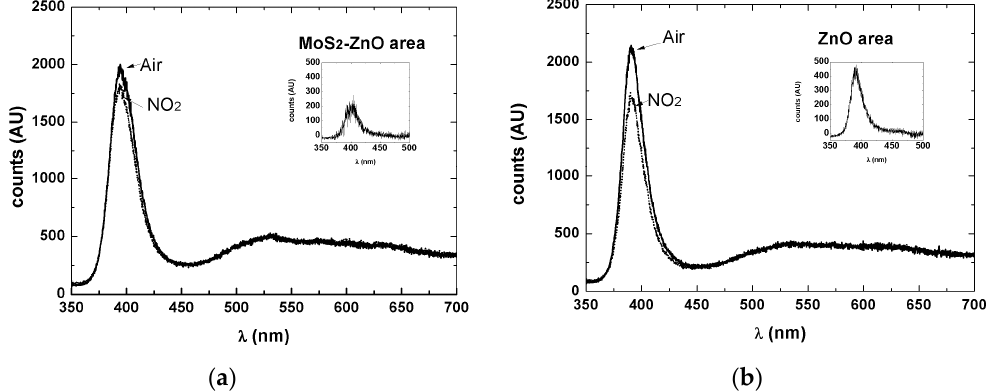
Figure 6. ( a ) Response to 10ppm NO 2 in dry air at 200 degC inside the MoS 2 ‐ ZnO structure reported in Figure 5 and ( b ) immediately outside on the ZnO. Insets report the difference of the signals. Setting as a feature the area under exciton (UV) peak (from 380 to 410nm) over the wavelength interval, the values reported in Table 2. can be extracted. The relative change of the chosen feature